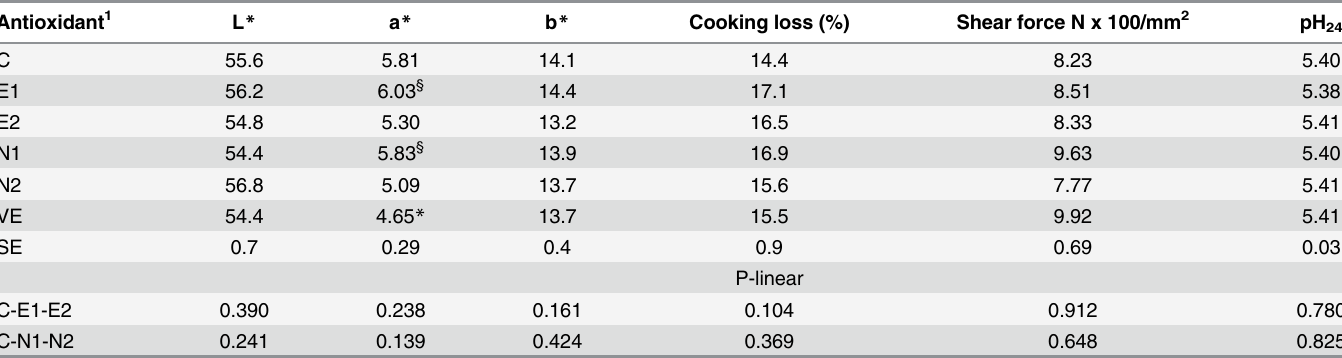
Table 3. Effect of dietary supplementation with naringin or hesperidin on broiler pectoralis major instrumental quality traits (n = 10). Antioxidant